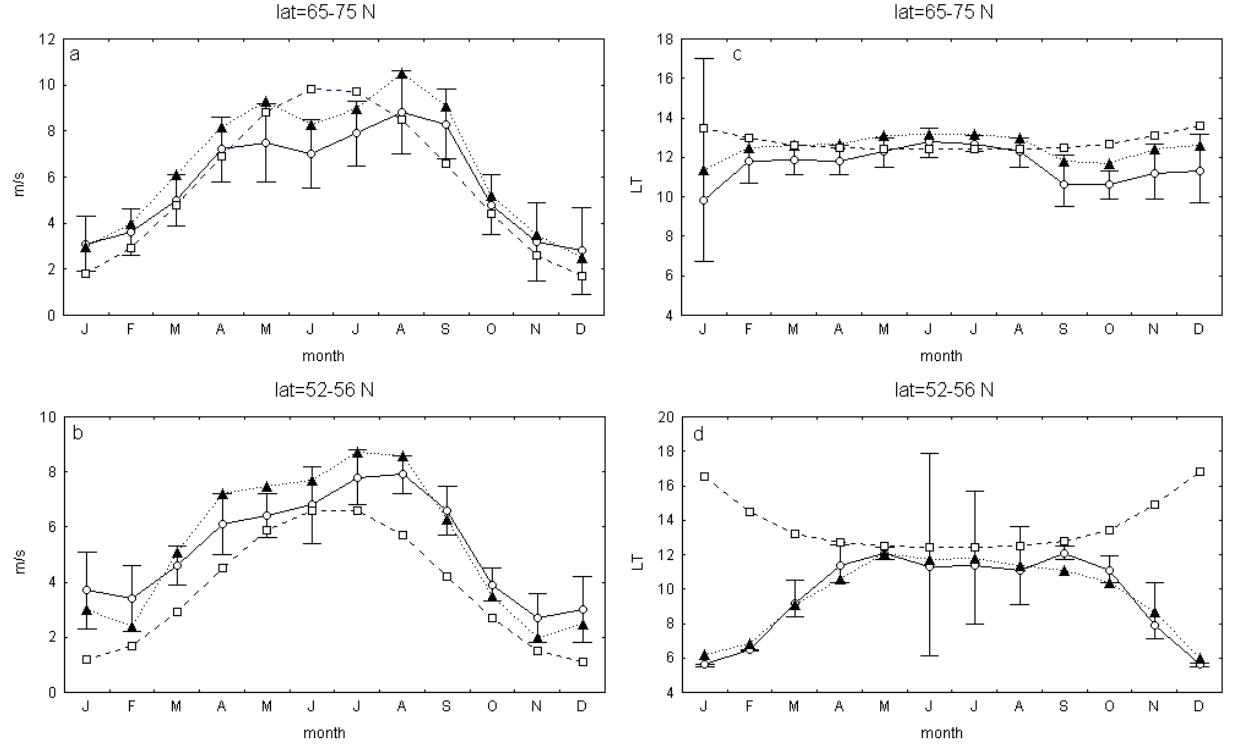
Fig. 13. The zonally averaged seasonal course of the diurnal tide at 90km; the error bars correspond to the r.m.s. errors for vector averaged values: ( a ) , ( b ) - amplitude of meridional component, ( c ) , ( d ) -phase of maximum of meridional component. − o − experimental data, − − HWM-93,... N ...GEWM-III